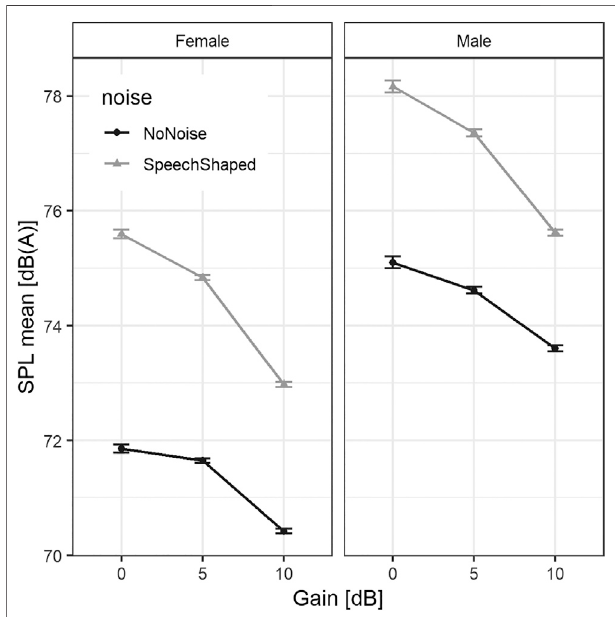
FIGURE2| MeanSPLindB(A)vs. roomgainregardingnoiseconditions and gender. The error bars indicate standard error.